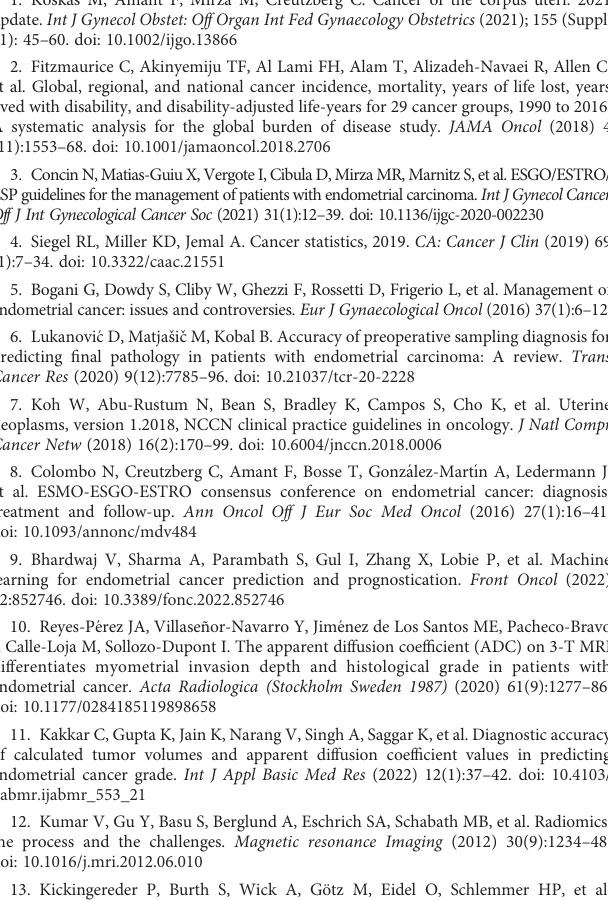
SUPPLEMENTARY FIGURE 1 (A) Radiomics features were selected by least absolute shrinkage and selection operator (LASSO) logistic regression model in the training set. (B) The penalty parameter log ( l ) was selected using 10-fold cross-validation through the minimum criterion, with the dashed line on the left representing the minimum log ( l ) and the dashed line on the right representing log ( l ) one standard error from the minimum. SUPPLEMENTARY FIGURE 2 The clinical decision curves of three models for predicting high-grade endometrial cancer in the training (A) and validation sets (B)